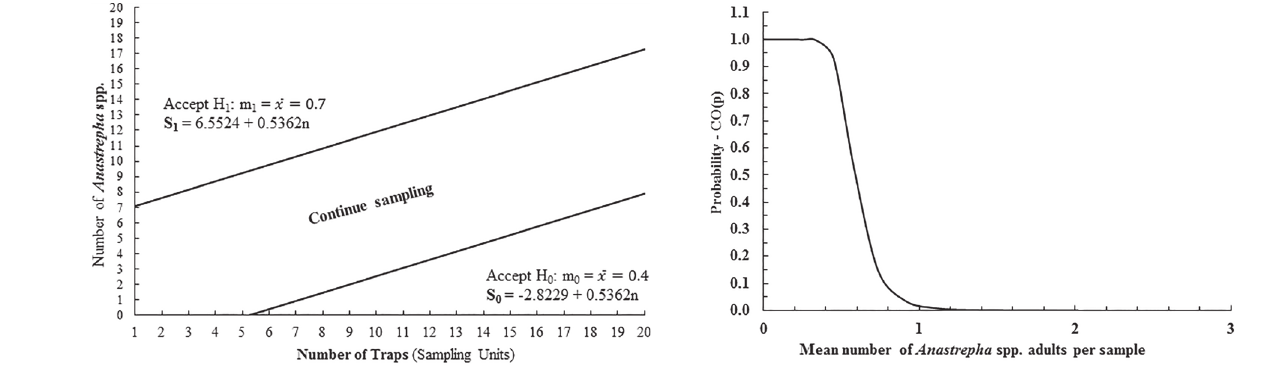
Figure 2 - Operating Characteristic Curve CO (p) of the Sequential Probability Ratio Test for populations of fruit fly species of the genus Anastrepha in ‘Novo Milênio’ guava cultivar for 23 weeks in three orchards in the region of Ivinhema, State of Mato do Sul, Brazil (August 2013 to January 2014).